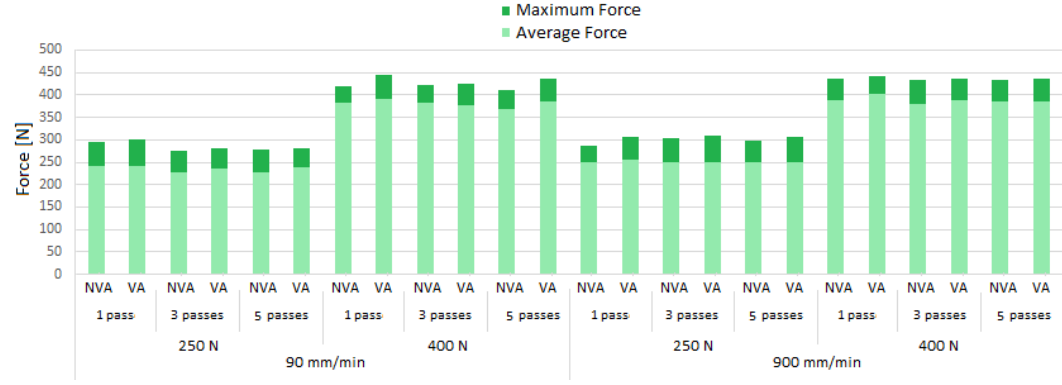
Figure 11. Average and maximum burnishing forces registered during all tests.